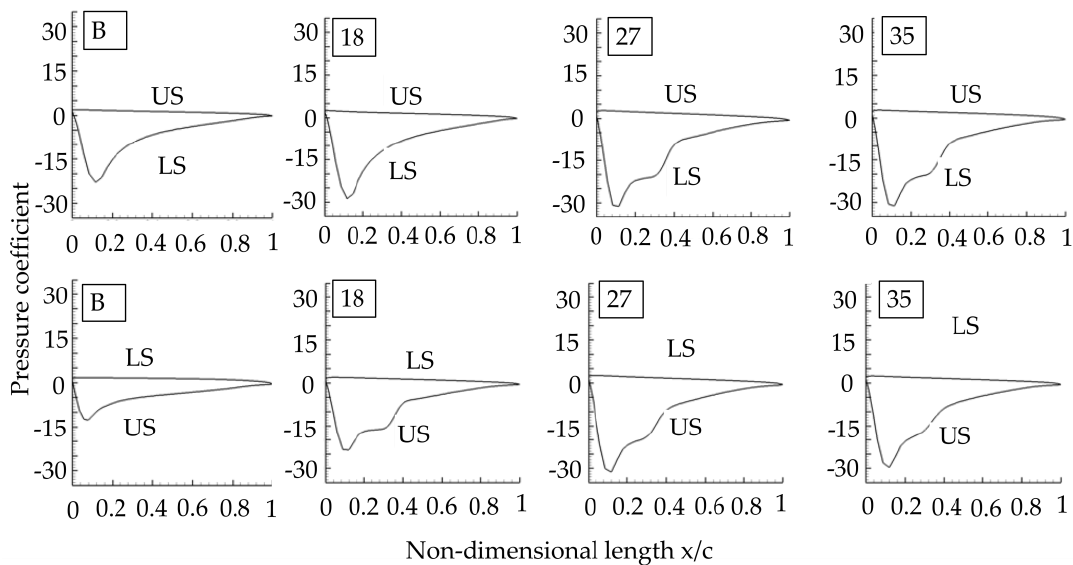
Figure 12. A comparison of the pressure distribution around the oscillating hydrofoil with a sin- gle/dual upstream deflector (upper surface (US) and lower surface (LS)) (First row: t / T = 0.2; second row: t / T = 0.65).